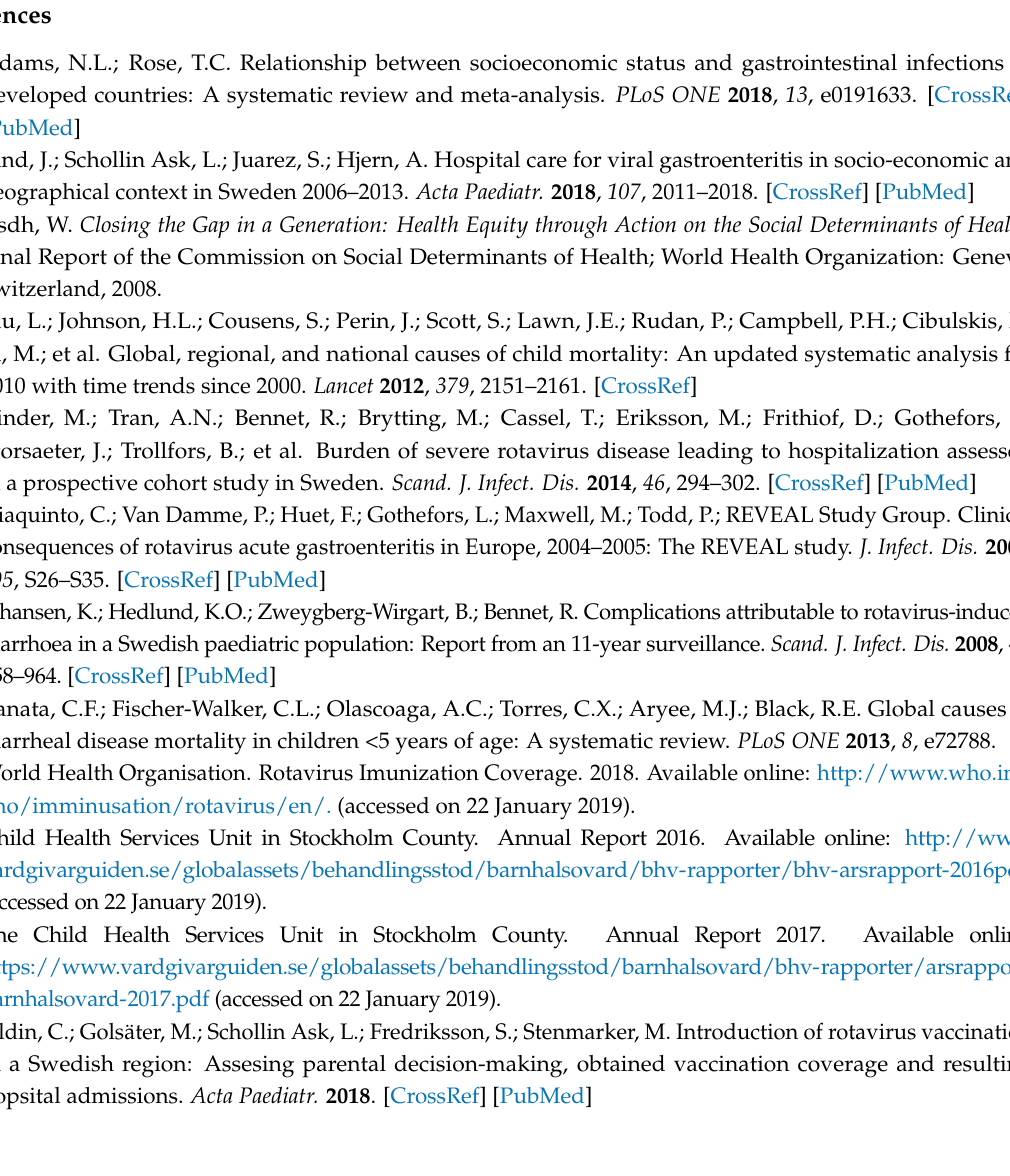
Table S1: Cox regression of the socioeconomic covariates related to paediatric inpatient and outpatient care of viral gastroenteritis in Jönköping County Council, Table S2: The study population of the sensitivity analysis. N = 519,128, Table S3: Sensitivity analysis of Cox regression of paediatric inpatient and outpatient care of viral gastroenteritis, Table S4: Sensitivity analysis of Cox regression of the socioeconomic covariates related to paediatric inpatient and outpatient care due to viral